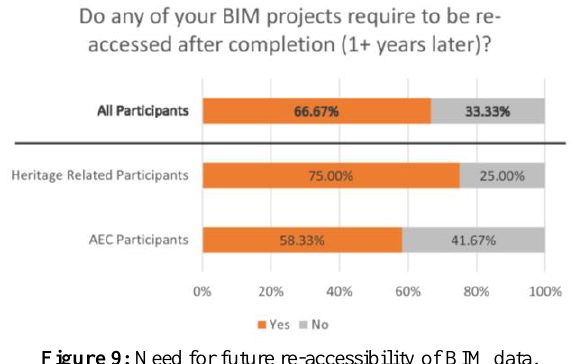
Figure 9: Need for future re-accessibility of BIM data.